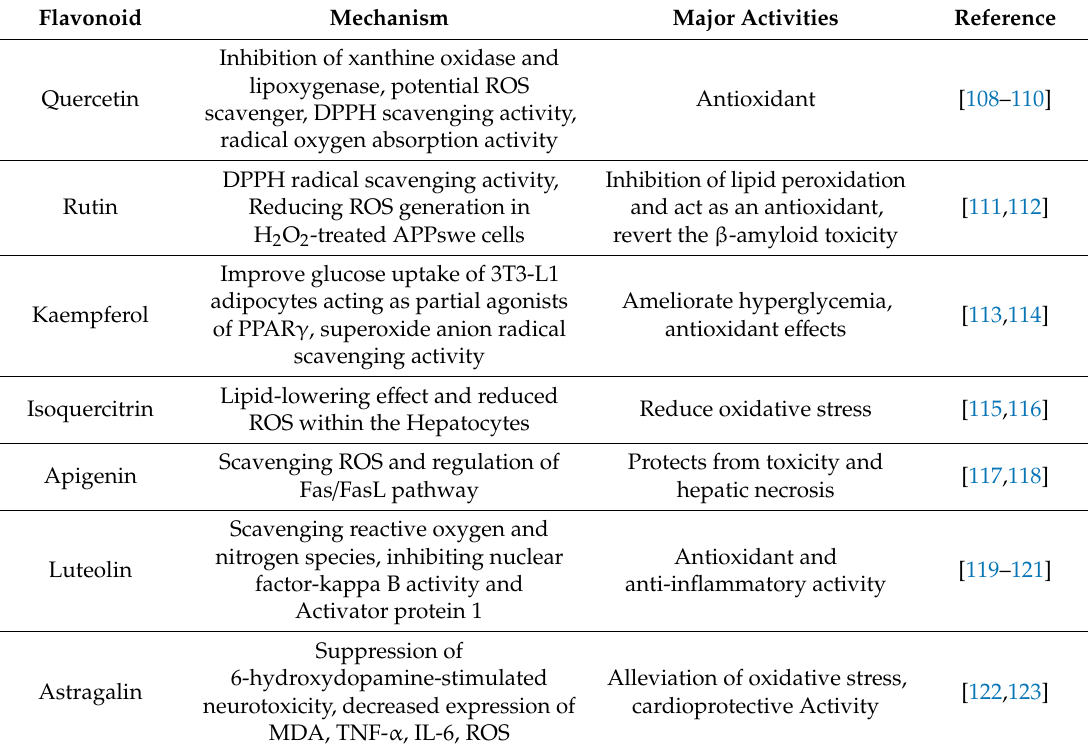
Table 3. Biological activities of major flavonoids present in mulberry leaf